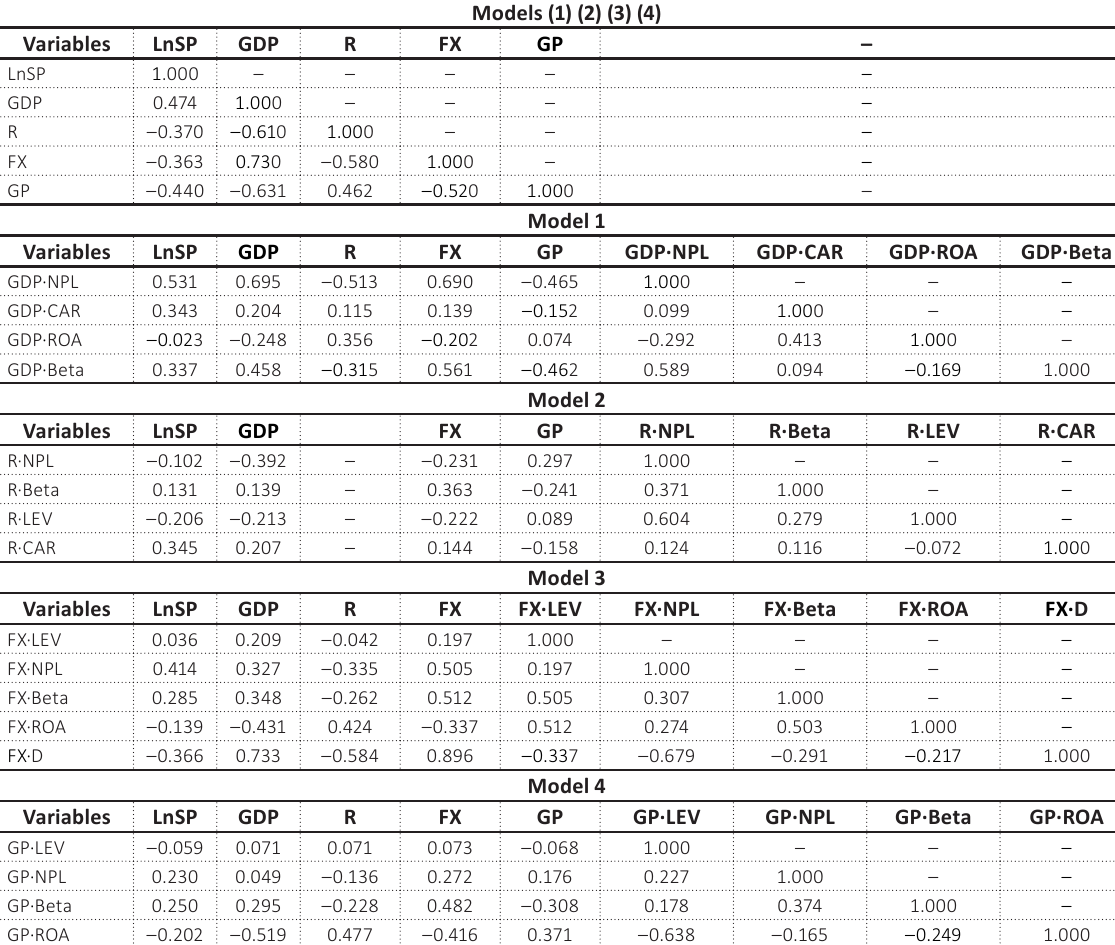
Table 3. Correlations among variables used in the